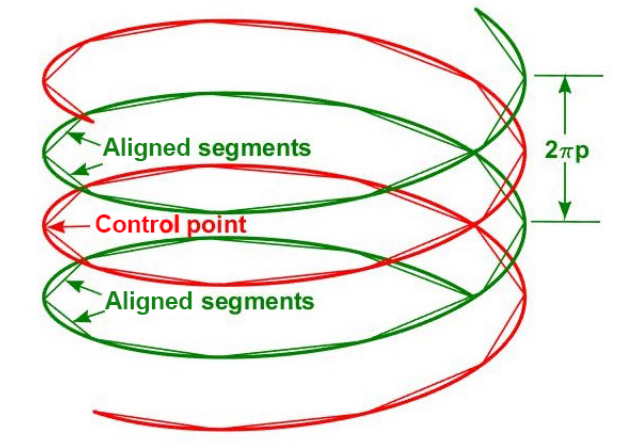
Figure 1. Schematic of two turns of constant radius helical vortices with p = 0 . 1 modelling the far wake of a wind turbine. N b = 2 and the straight segment approximation is shown for N s = 10. The flow is down the page. The “control point” is where the induced velocity is required. The contribution from the “aligned segments” on either side of the control point require the largest second curvature correc- tion.